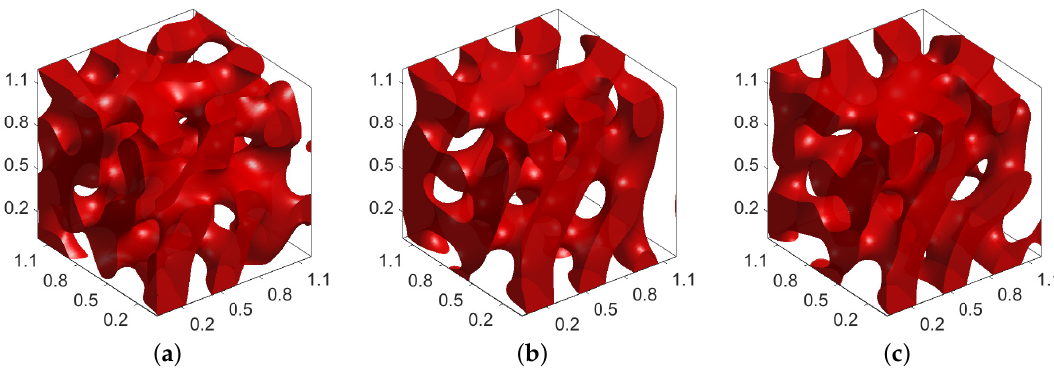
Figure 31. ( a – c ) are the snapshots of the lamellar pattern formation via nonlocal CH equation at t = 100 ∆ t , 1000 ∆ t , and 10,000 ∆ t , respectively.